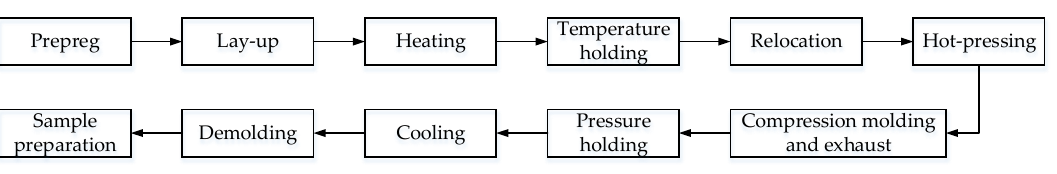
Figure 5. The compression molding process.